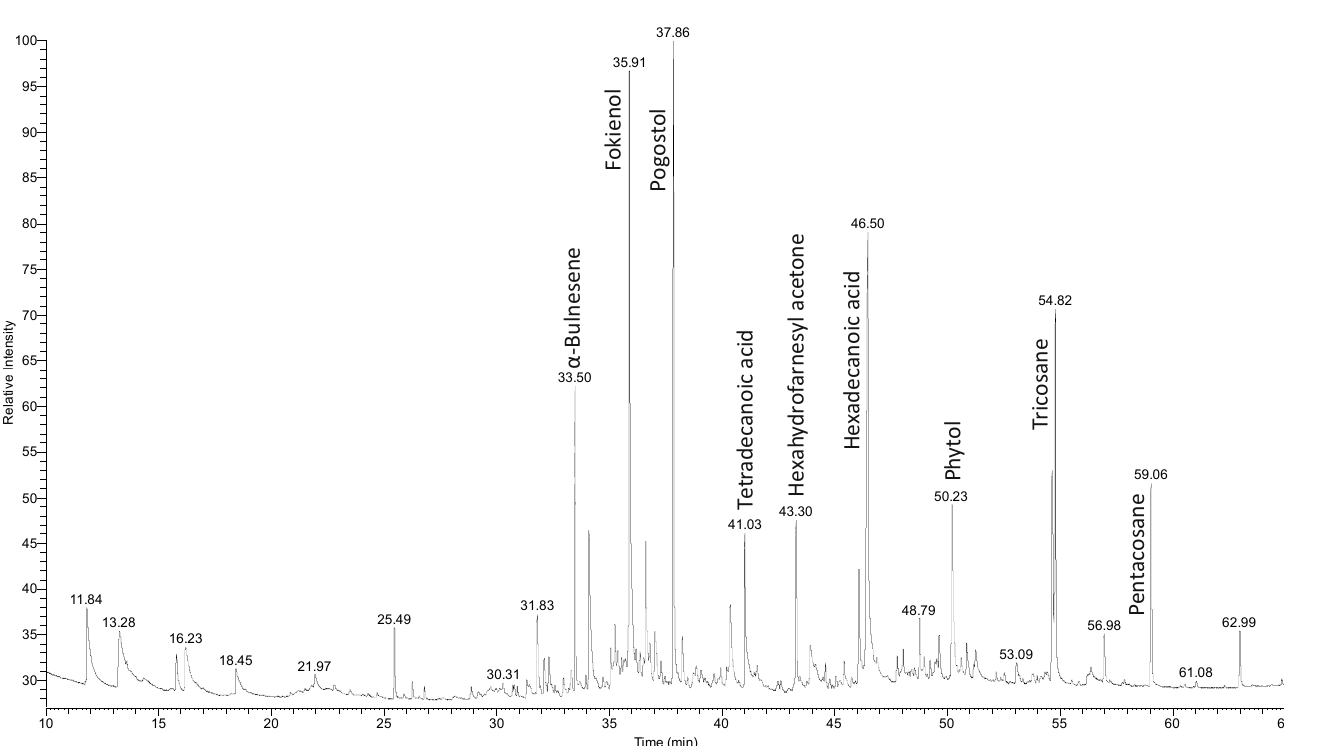
Figure 1. GC-MS chromatogram of an essential oil of O. pseudoglandulosa . Table 1. Chemical components of volatile oil in O. pseudoglandulosa.